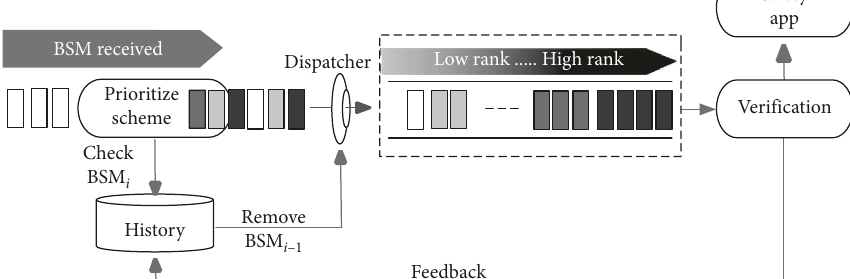
Figure 5: History-based verification